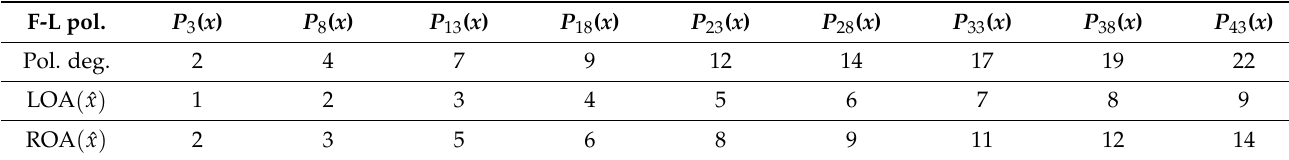
Figure 10. Using Maple to determine OAs of the root of P 3 ( x ) . Table 1. The LOAs and ROAs for the smallest root of P 3 ( x )